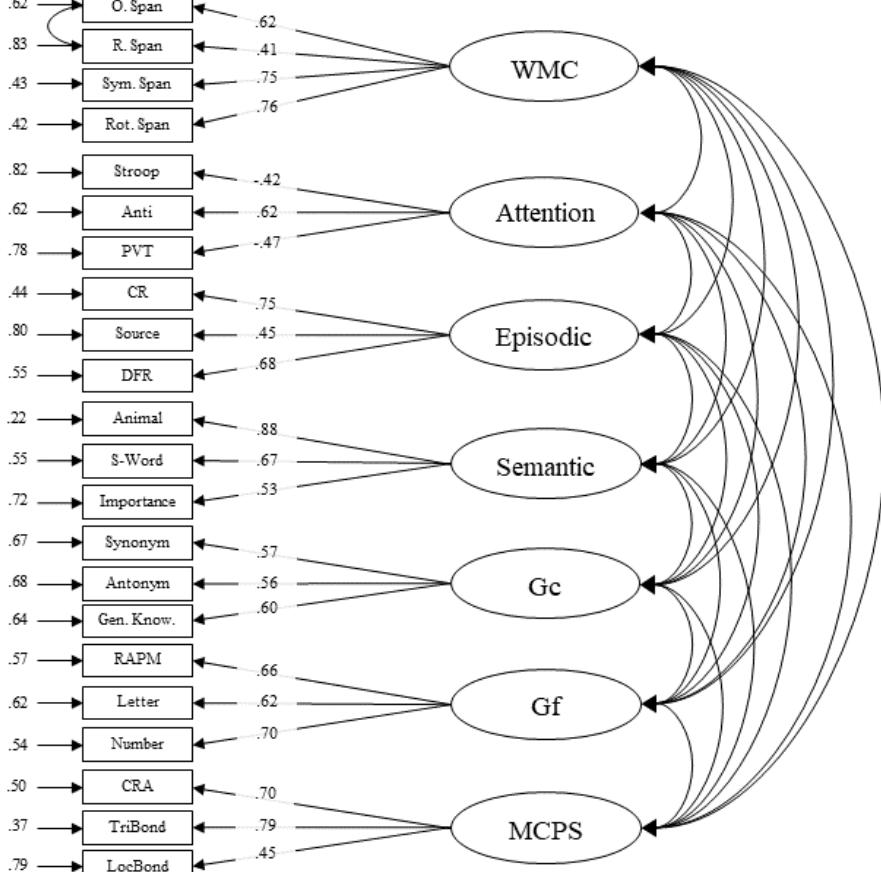
Figure 1. Confirmatory factor model (2) that was retained after fit comparisons. Single-headed arrows on the left-side of boxes (manifests) represent error variance. Single-headed arrows from circles (latent factors) to boxes (manifests) represent the standardized factor loadings. PVT: Psychomotor Vigilance; CR: Cued Recall; DFR: Delayed Free Recall; RAPM: Raven’s Progressive Matrices; WMC: working memory capacity; Gc: crystallized intelligence; Gf: fluid intelligence. The “A” in CRA A, TriBond A, LocBond A, and MCPS A stands for analytical, while the “I” in CRA I, TriBond I, LocBond I, and MCPS I stands for insight.